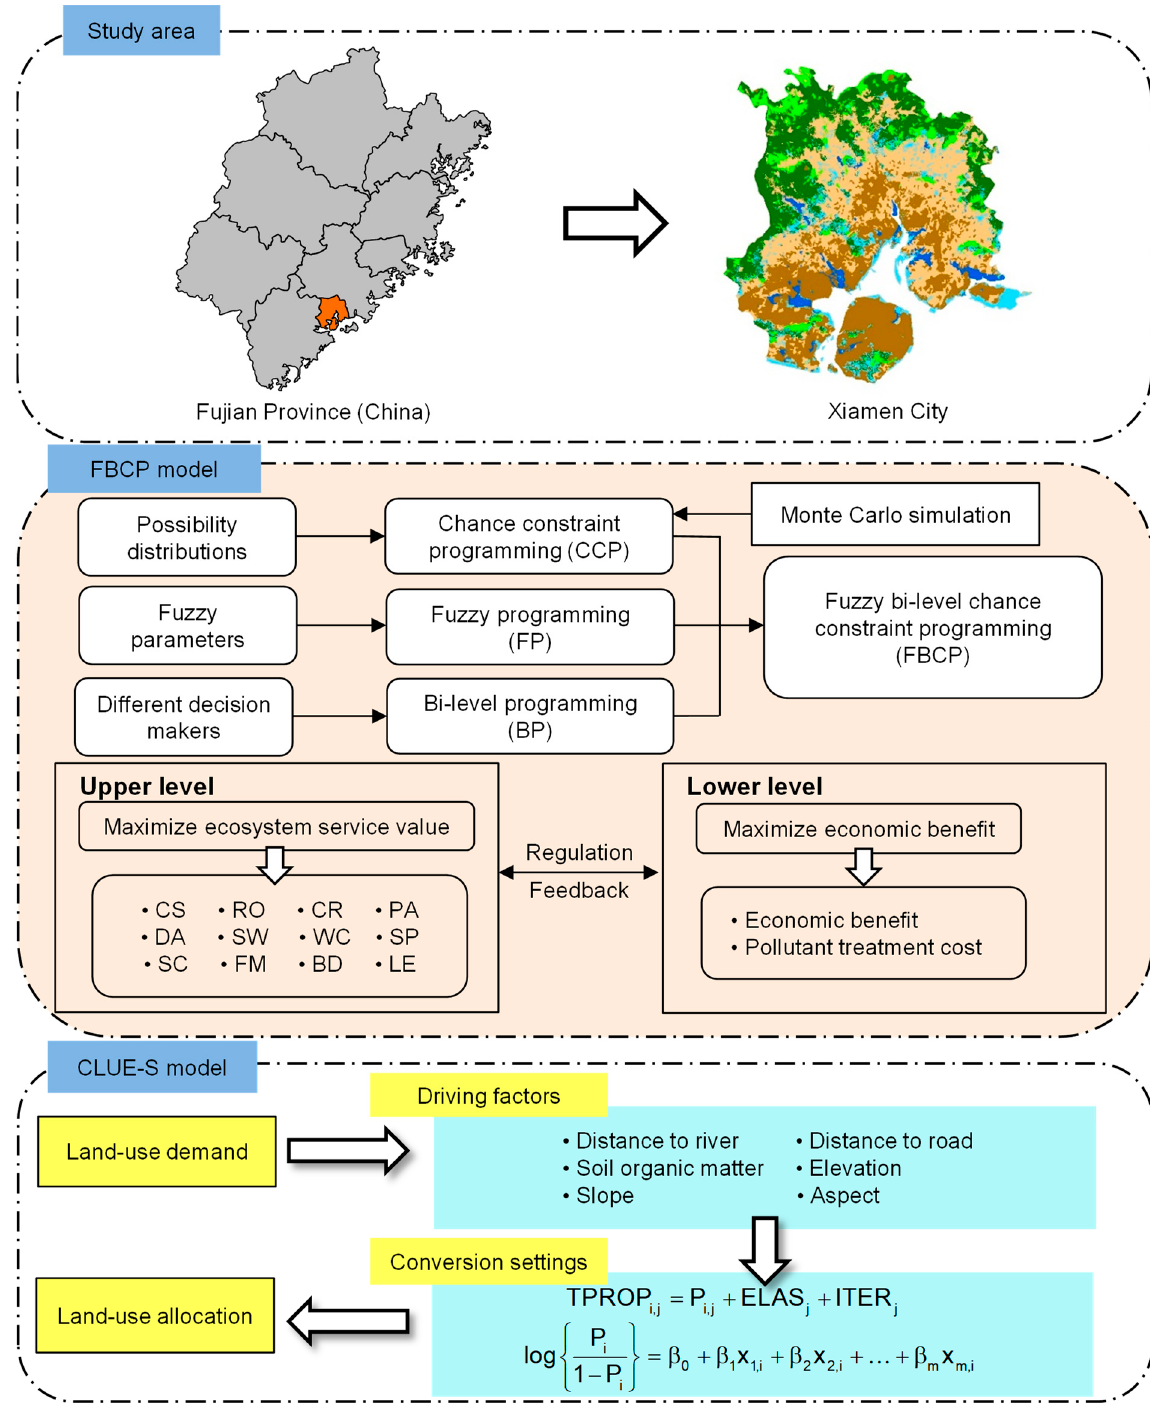
Figure 1. Framework of the FBCP–CLUE-S model. Upper level: